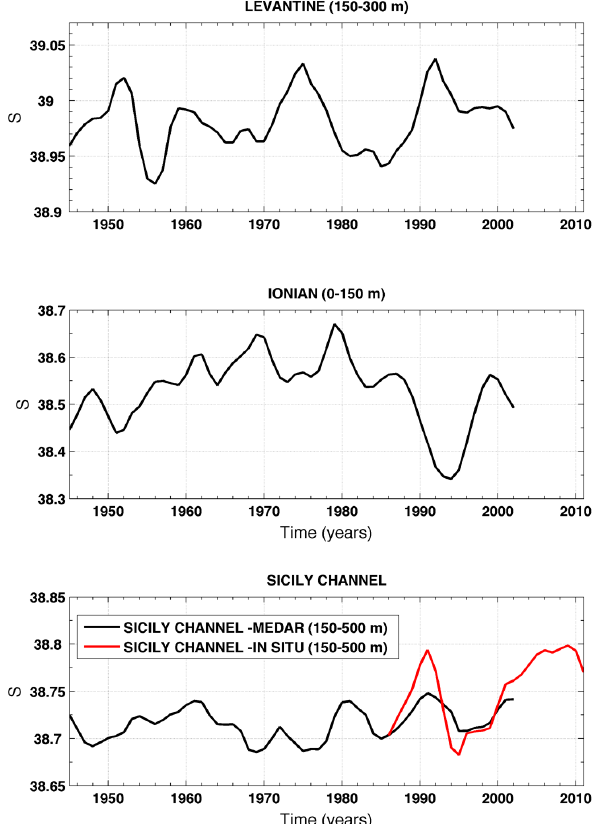
Fig. 3. Time series of the mean salinity values (see Fig. 1 for the averaging areas) for the Levantine (depth interval 150–300m) and Ionian (surface – 150m) subbasins as well as for the Sicily Chan- nel (150–500m). The data are low-pass filtered with a three-year running